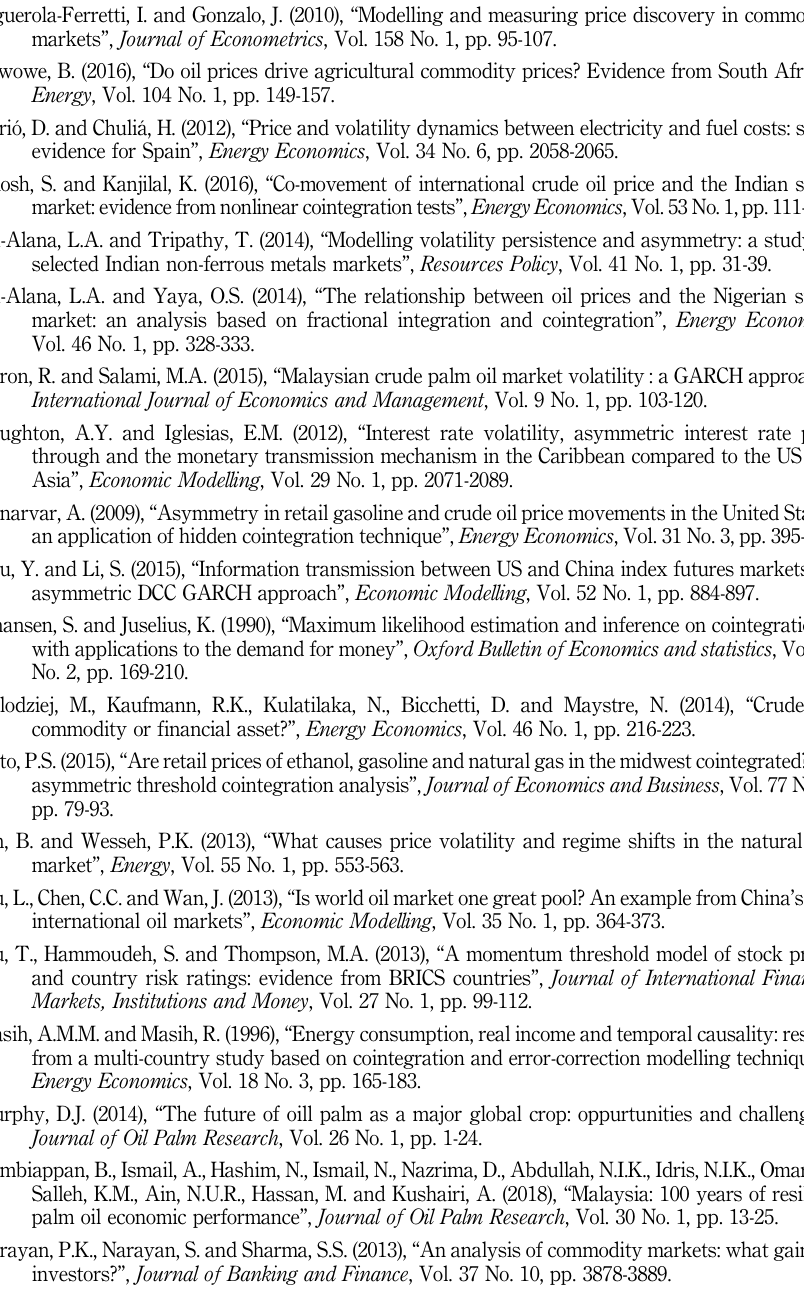
Figuerola-Ferretti, I. and Gonzalo, J. (2010), “ Modelling and measuring price discovery in commodity markets ” , Journal of Econometrics , Vol. 158 No. 1, pp.